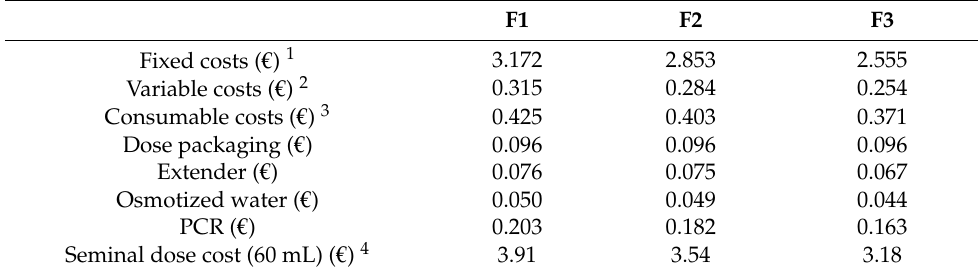
Table 6. Calculation of a seminal dose cost depending on the ejaculate fraction/s included (F1 vs. F2 vs.